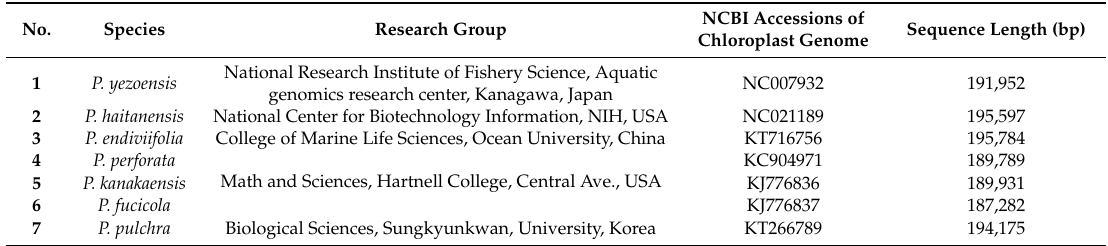
Table 1. Complete and partial chloroplast genomes of the seven Pyropia species used in this study. No. Species Research Group